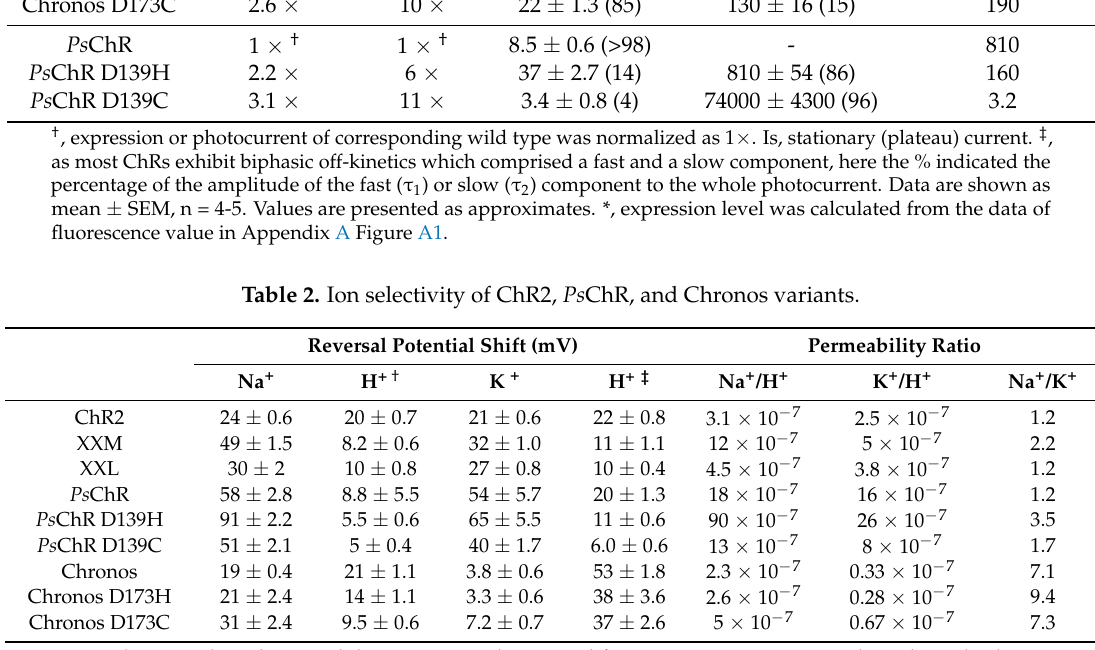
as most ChRs exhibit biphasic off-kinetics which comprised a fast and a slow component, here the % indicated the